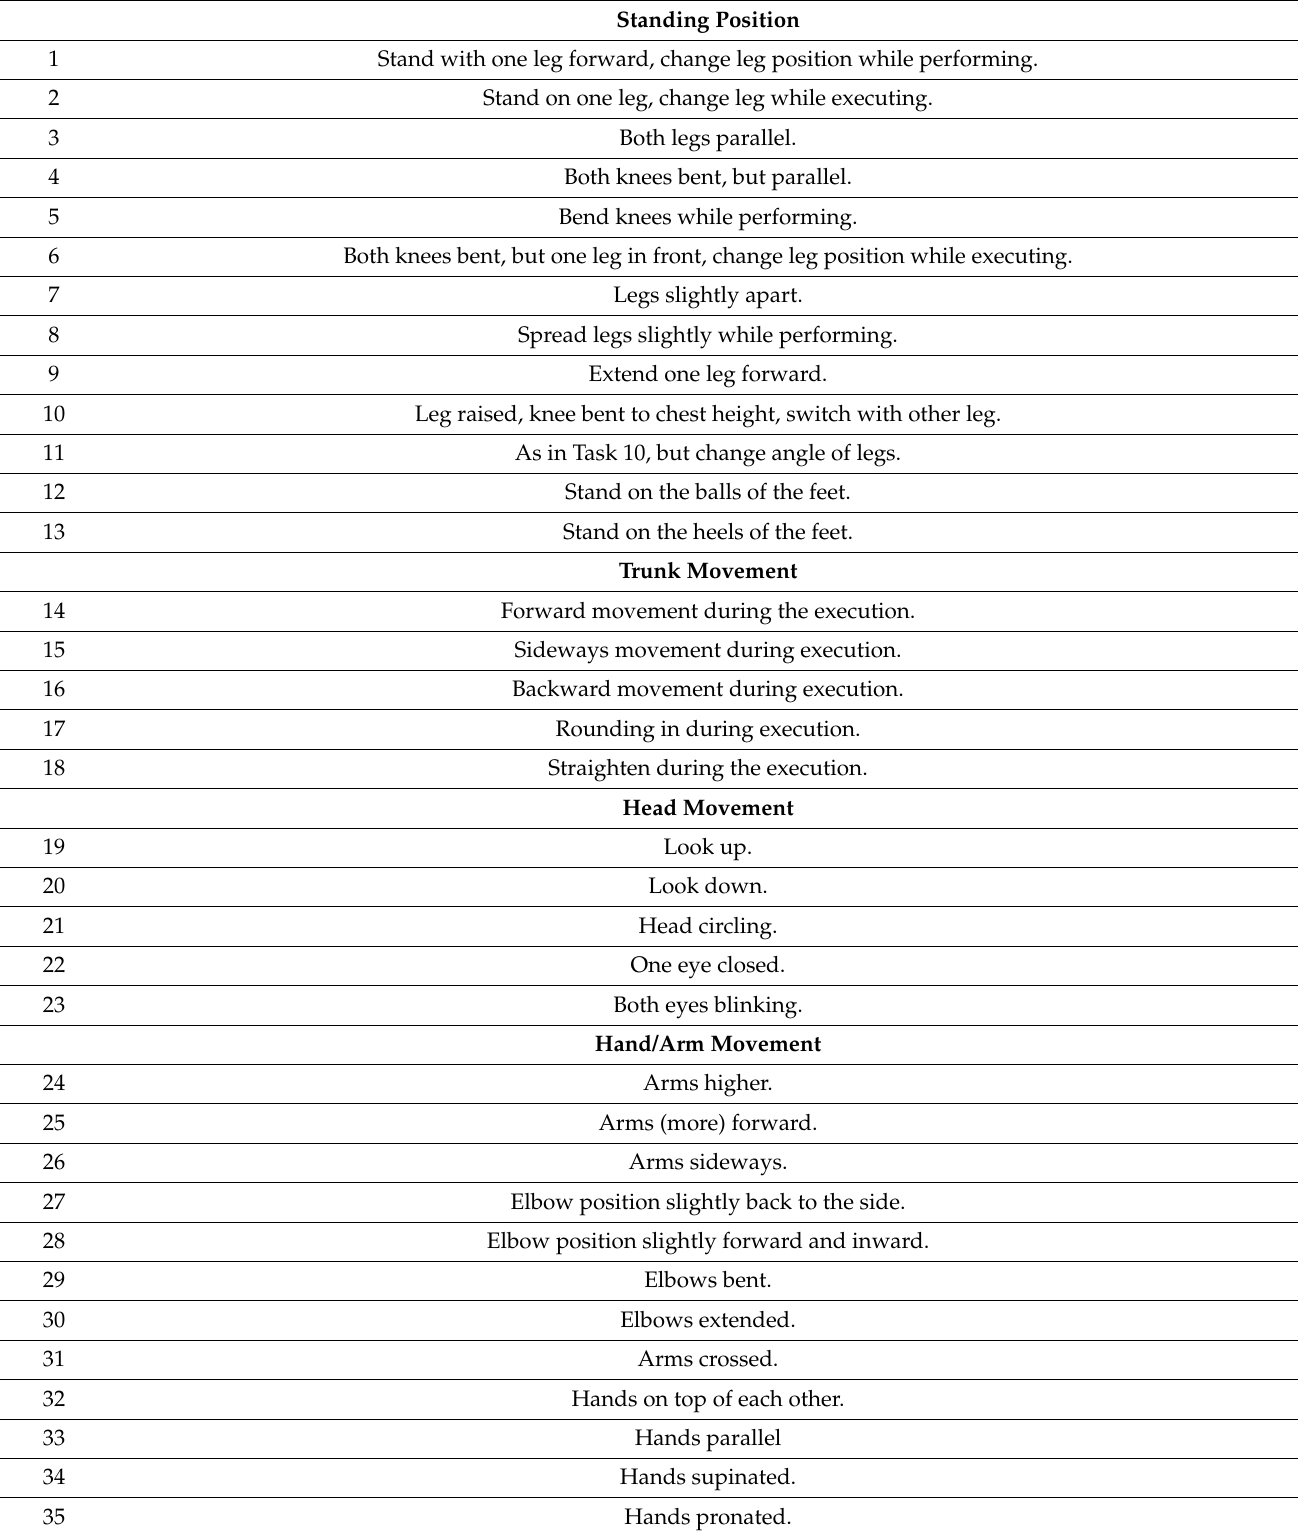
Table A1. Training exercises for the DG for the techniques underhand pass, overhand pass, and overhand service divided into different